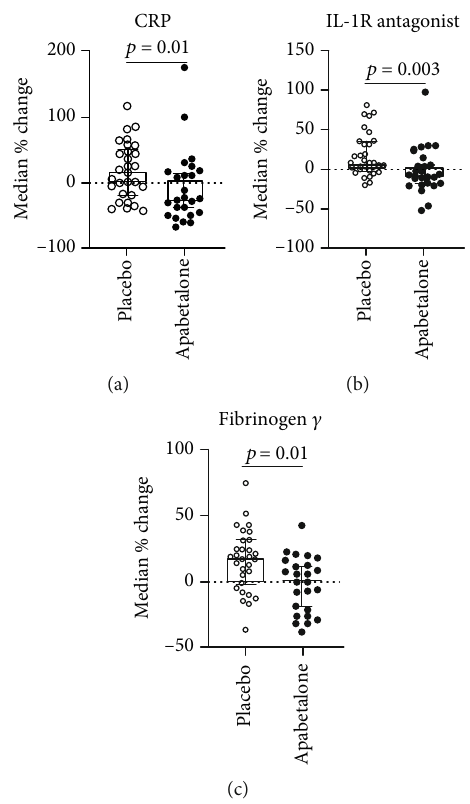
Figure 4: Apabetalone treatment reduces the abundance of liver-derived APR plasma proteins in CAD patients versus placebo. (a – c) Boxes represent median values of percent changes between start and end of study in each patient. Lines represent the 95% con fi dence